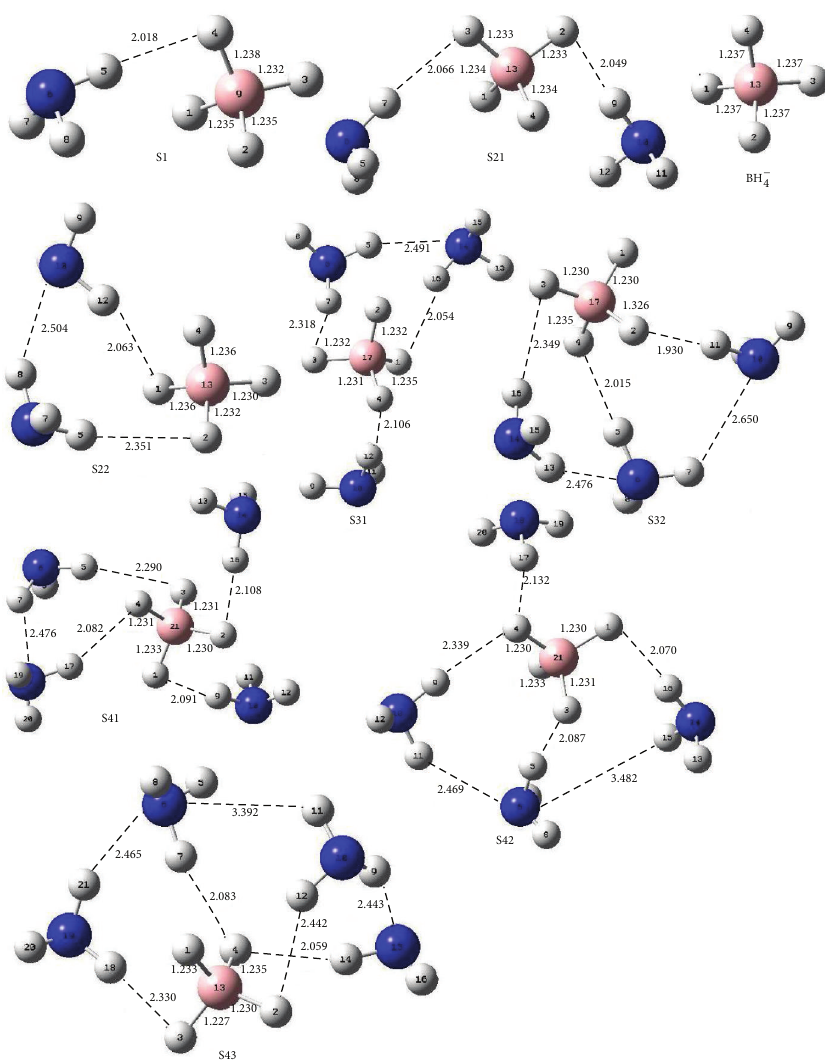
Figure 1: Geometries of clusters of BH 4− with NH 3 optimized at MP2/6-311++g(d,p)